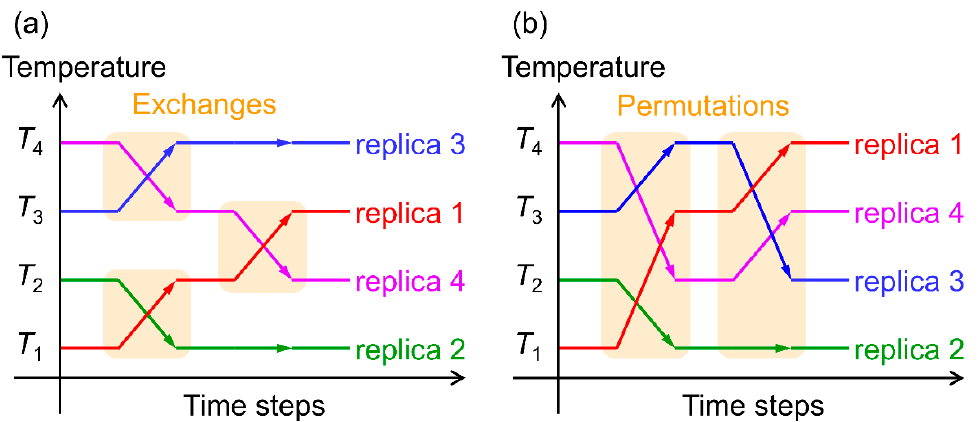
Figure 2. ( a ) Schematic illustration of time series of temperatures in the replica-exchange method. Orange squares mean replica exchange trials with the Metroplis algorithm. ( b ) Schematic illustration of time series of temperatures in the replica-permutation method. Orange rectangles mean replica permutation trials with the Suwa–Todo algorithm.